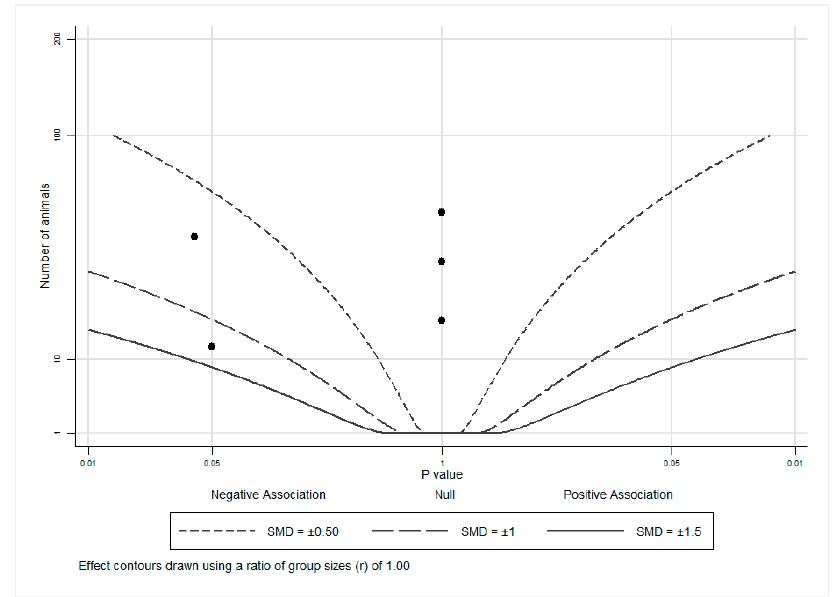
Figure 2. Albatross plot for animal studies. Each point represents a single study, with the effect estimate (represented as a p -value), plotted against the total given sample size ( n ) included within each study. Contour lines are standardized mean differences (SMD). p -values reported as <0.05 were plotted as 0.05 as a conservative estimate, while non-significant (null) p -values were plotted as 1.